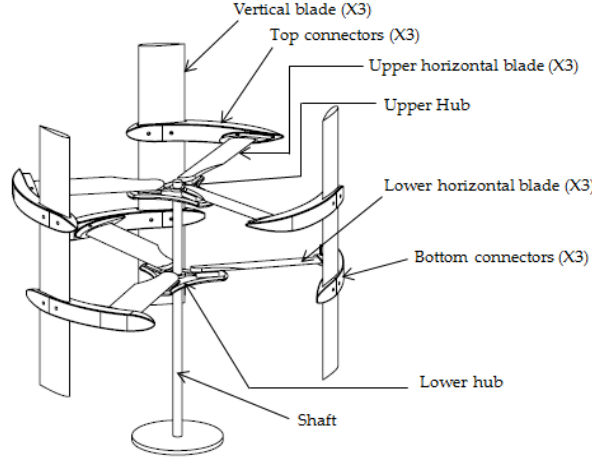
Figure 3. General arrangement of the CAWT.